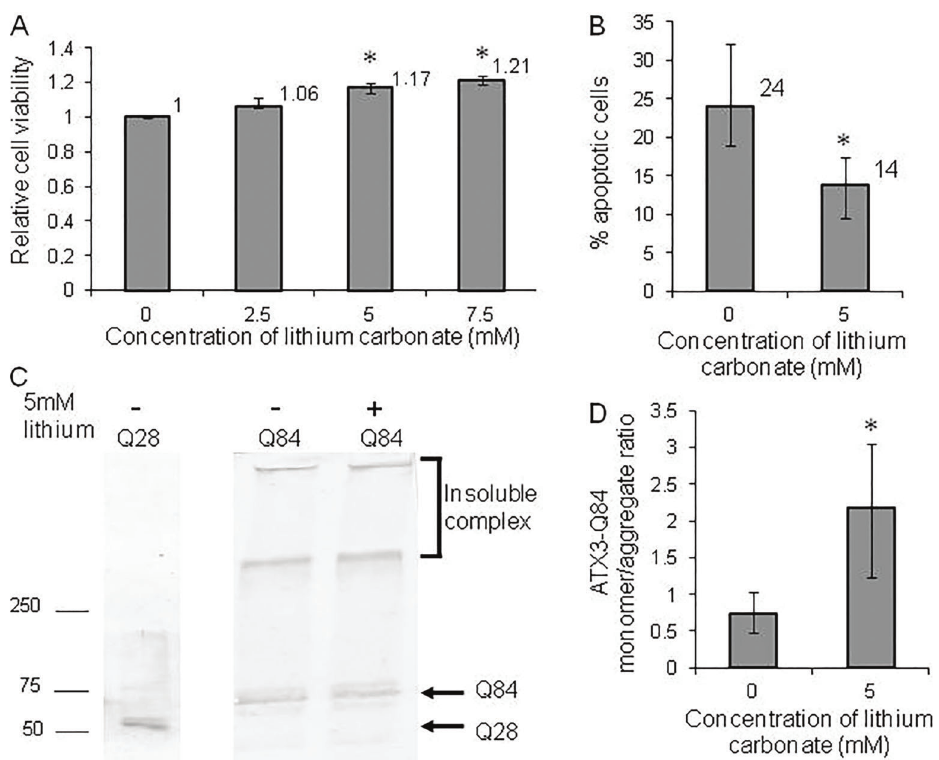
Figure 2. PC12 cells transfected with full-length expanded ATX3 (Q84), treated with different concentrations of lithium carbonate and analyzed after 48 h. A , Relative cell viability by the MTT assay. B , Percentage of apoptotic cells analyzed by fl ow cytometry after Annexin V and propidium iodide staining. C , ATX3-Q84 monomer/aggregate ratio analyzed by western blotting. D , Band densitometry was calculated with ImageJ software, and data of monomer/aggregate ratio were plotted in a graph. All experiments were performed in triplicates and data are reported as means ± SE. *P o 0.05, Kruskal-Wallis